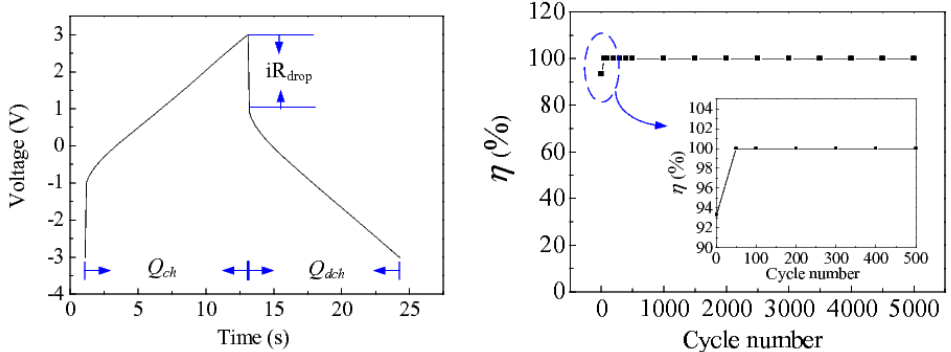
Figure 7. ( a ) Charging and discharging curves of the NiO/MCMB elextrodes ( b ) The relation of charge/discharge ( η ) and life-times in the NiO/MCMB elextrode.